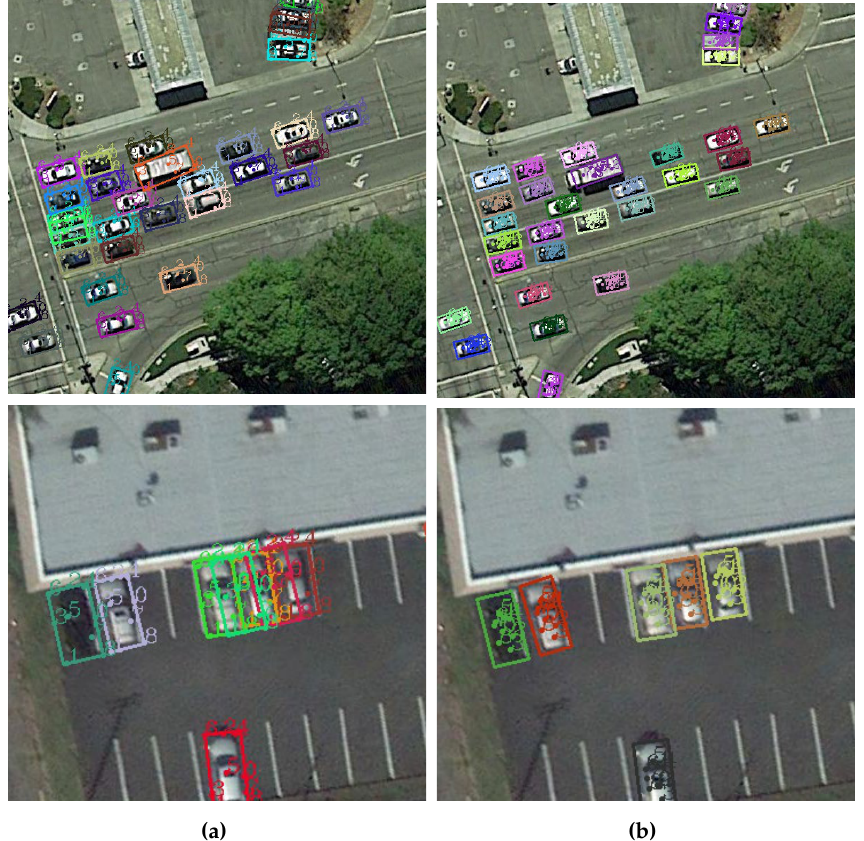
Figure 6. Comparison of the visualization results of PointSet and G-Rep on the UCAS-AOD